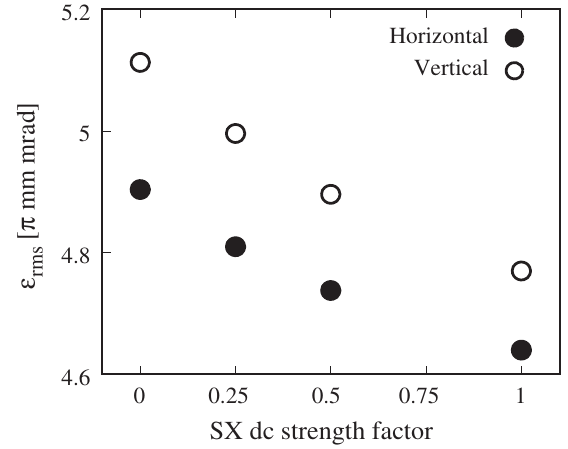
FIG. 26. Transverse ϵ of the circulating beam at the rms extraction energy obtained in the simulation as a function of the degree of chromaticity correction controlled by a SX dc field. Disregarding KM impedances, which are not included in these results, fully corrected ξ at the injection energy leads to the minimum beam emittances extracted from the RCS.